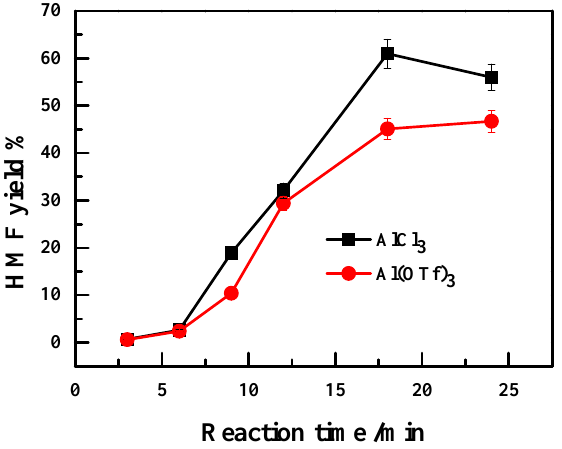
Figure 6. Effect of the anion style of Lewis acid salts on the yield of HMF. Reaction conditions: reaction temperature of 160 °C, reaction time of 25 min, 0.1 g glucose in 1.5 g 25 mM Lewis acids aqueous solution, 3 g sec-butyl phenol.